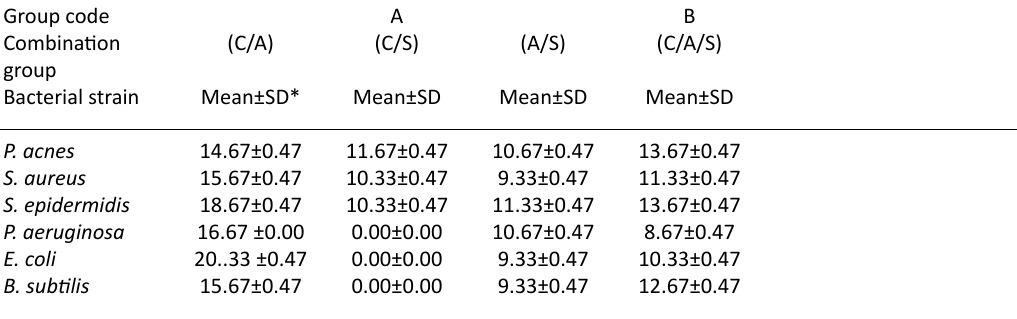
Table 4. Antimicrobial susceptibility of acetonic extract of combinations against the bacterial isolates Group